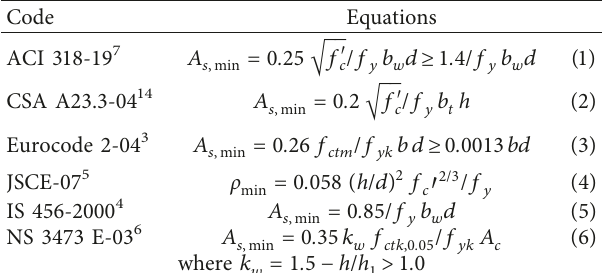
Table 1: Equations of the design